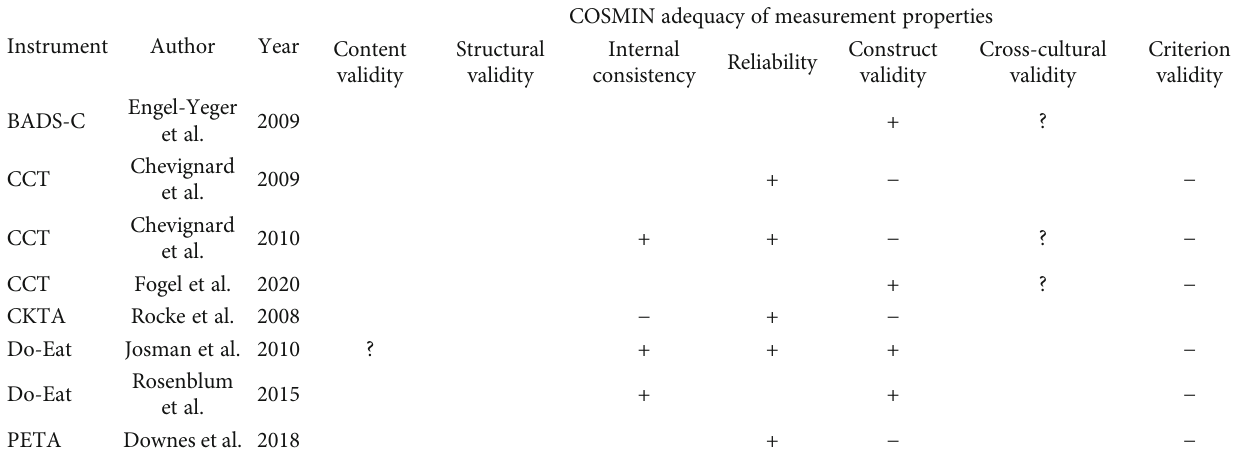
Table 3: Summary of adequacy of EF tools ’ measurement properties.